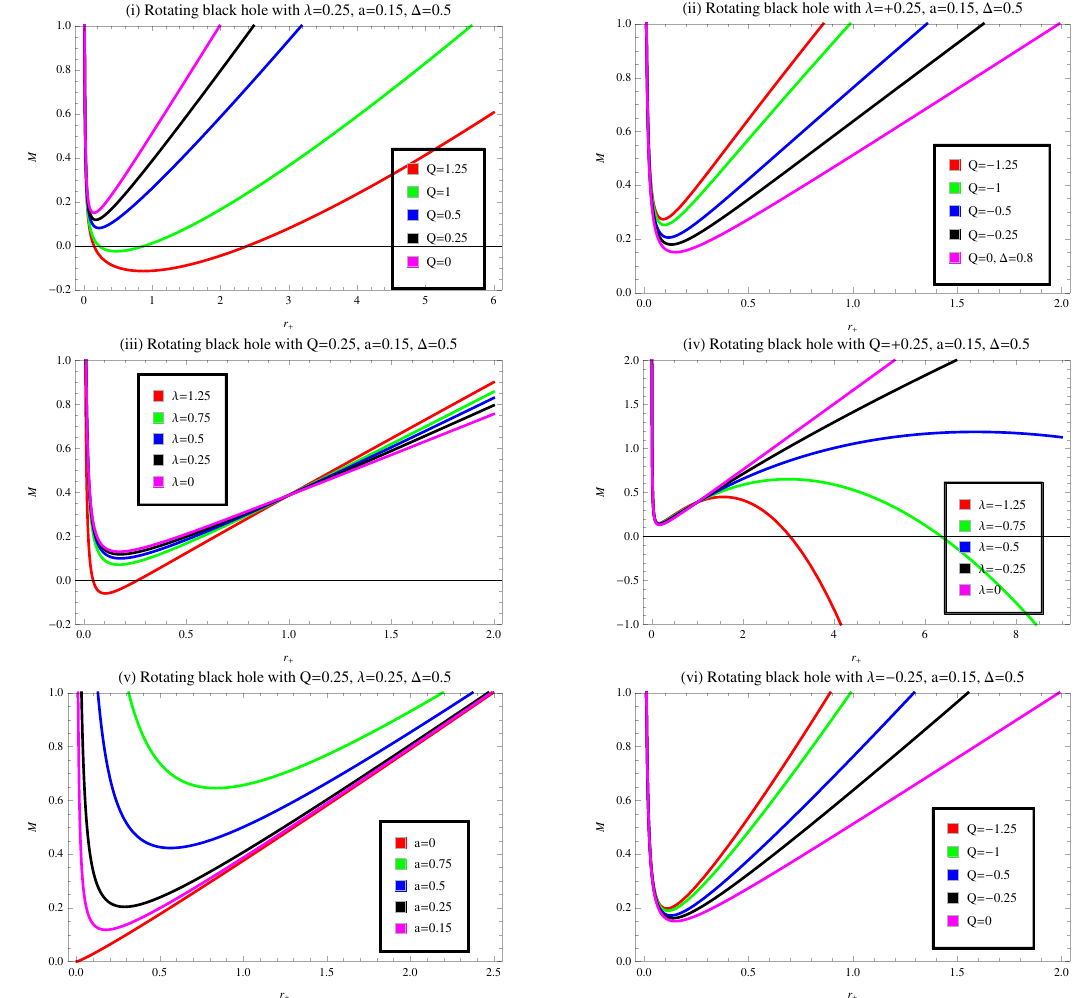
Figure 6. Plot of mass M versus horizon radius r + for rotating regular BH in the presence of CMG